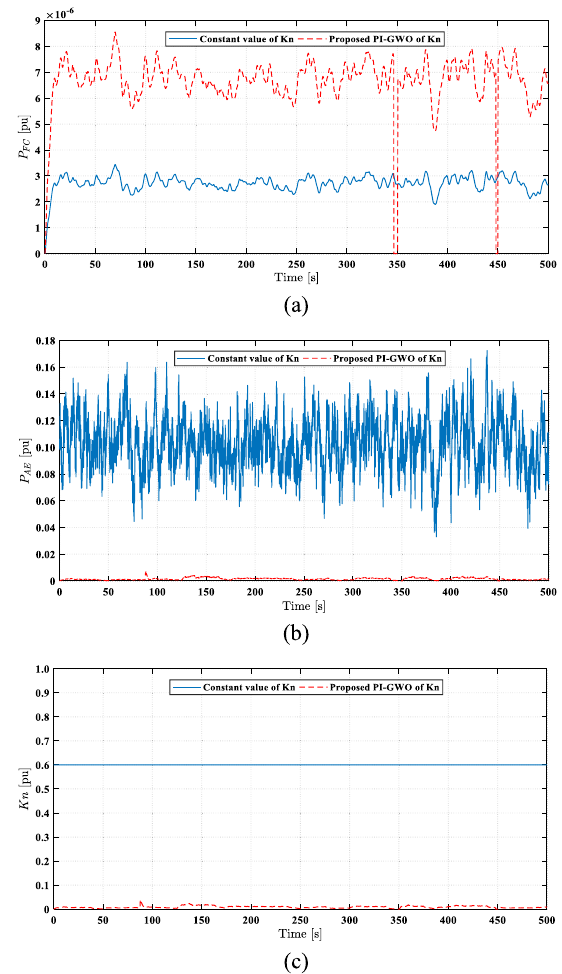
Fig. 20 The Case 4 response of a fuel cell power, b power fed to AE, and c value of